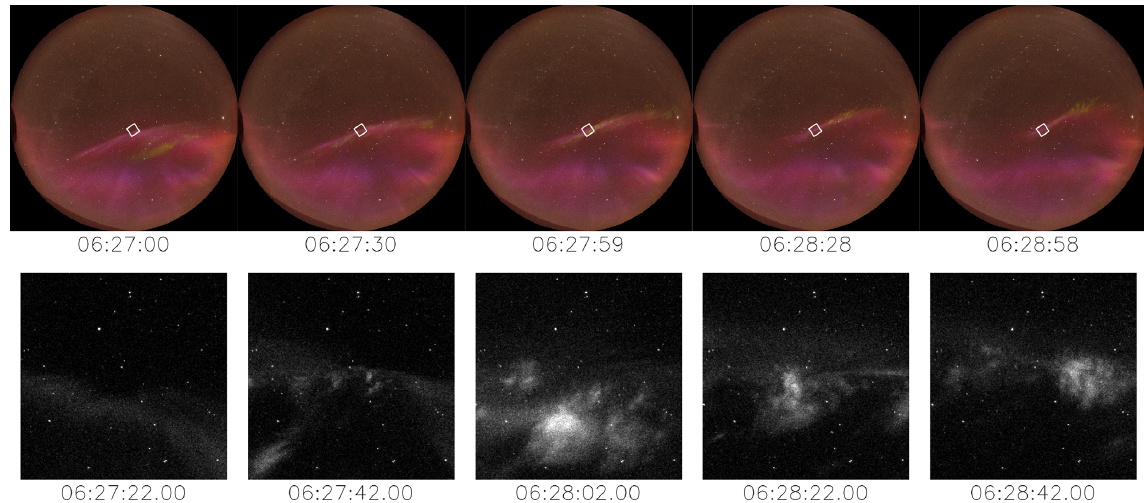
Figure 3. Event 2 on 22 December 2014. As for Fig. 1, the top row shows colour all-sky camera images, with the time at the start of the exposure given below each frame. The bottom row shows selected ASK images of the N 2 1P emission at 673.0nm. The ASK field of view is indicated in the all-sky images as a white box.